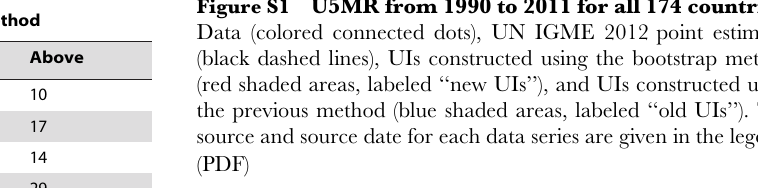
target of an ARR of 4.4% is deemed unlikely, not clear, or likely based on all available data. Figure S1 U5MR from 1990 to 2011 for all 174 countries. Data (colored connected dots), UN IGME 2012 point estimates (black dashed lines), UIs constructed using the bootstrap method (red shaded areas, labeled ‘‘new UIs’’), and UIs constructed using the previous method (blue shaded areas, labeled ‘‘old UIs’’). The source and source date for each data series are given in the legend. (PDF) Table S1 Estimates and uncertainty intervals for all countries for the U5MR in 1990, 2000, and 2011, and the ARR from 1990 to 2011. (DOCX) Text S1 Supplementary information on the construc- tion of the uncertainty intervals. (PDF)